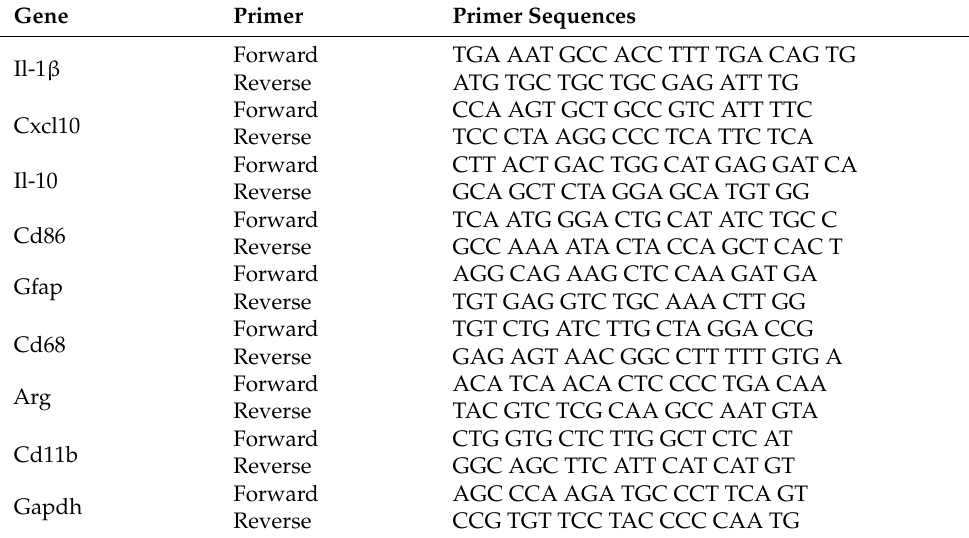
Table 1. Primer list used in this